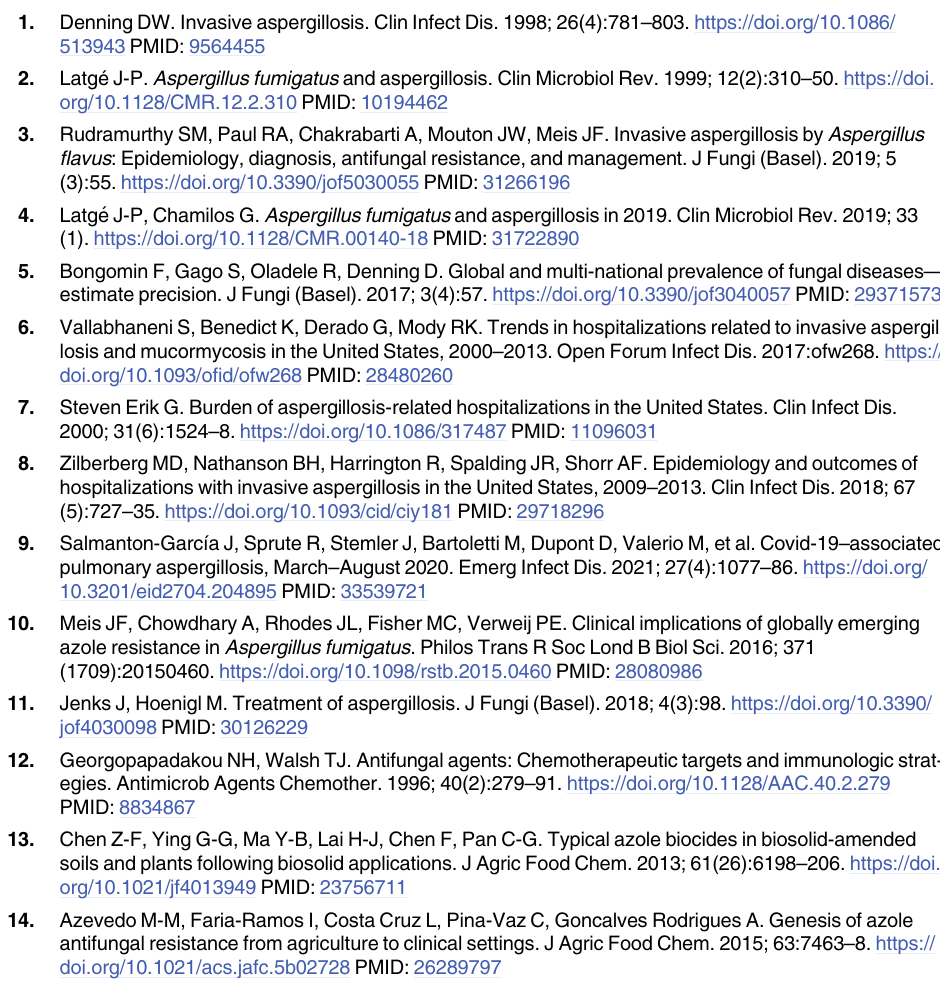
S1 Table. Environmental setting, substrate, geographic origin, and cyp51A genotype of azole-resistant Aspergillus fumigatus reported in the